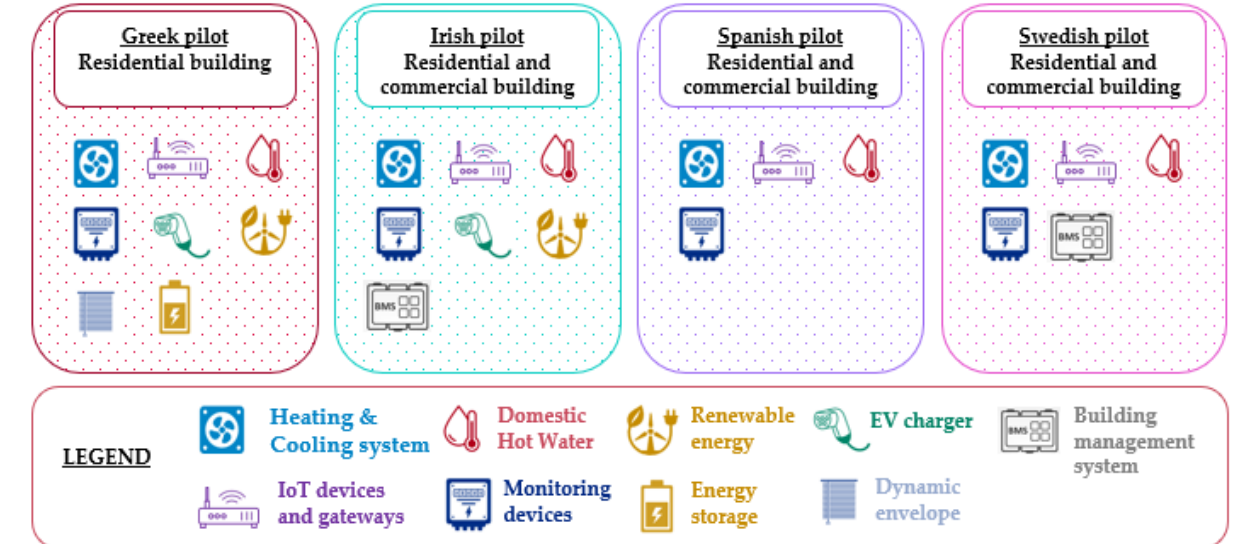
Figure 5. Pilots’ type of use and field devices.